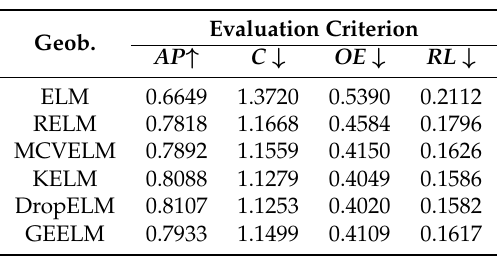
The effectiveness comparison of ELM and its variants on the Geobacter sulfurreducens dataset.